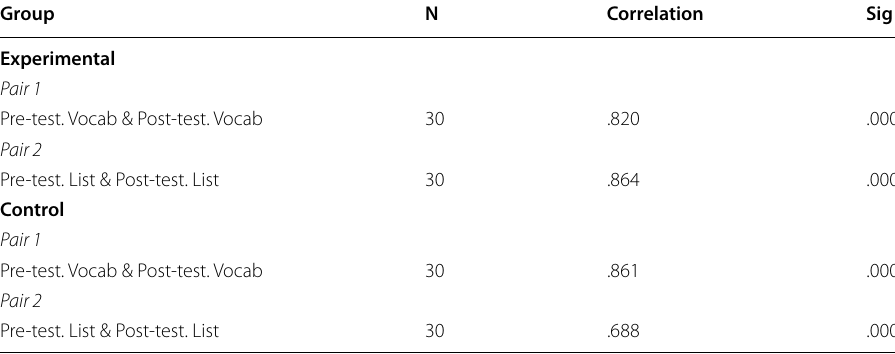
Table 5 Paired Samples Correlations